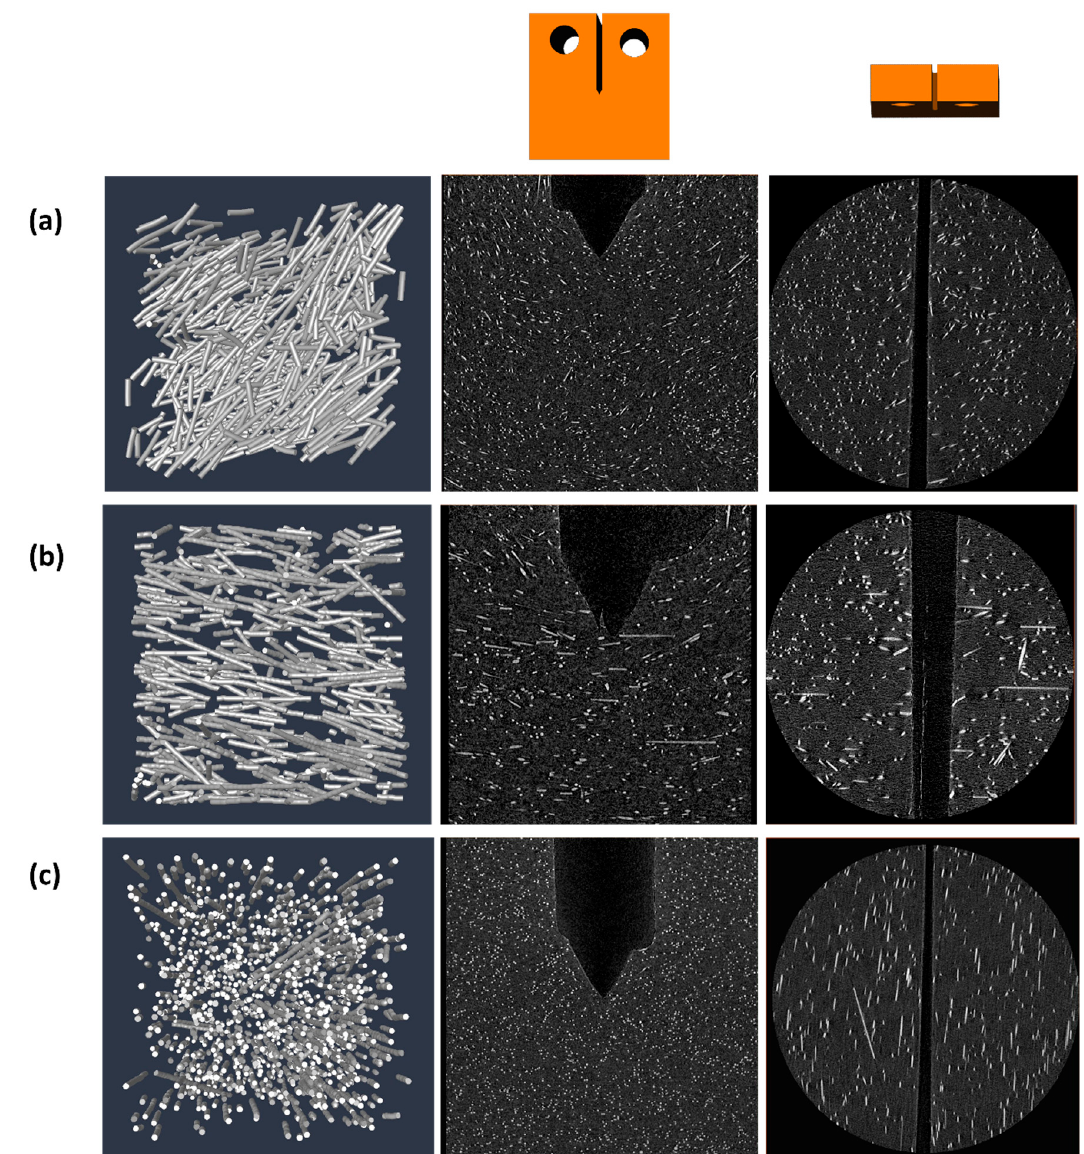
Figure 6. Visualization of fiber orientation by means of Computed Tomography. The left column depicts trace-lines of the fibers from a small representative volume near the crack-tip, the middle column depicts a slice of the XY -plane, and the right column a slice of the XZ -plane above the crack-tip. Each row displays a different magnetic configuration: ( a ) arbitrary orientation in the absence of magnetic field; ( b ) unidirectional alignment with the X -axis, parallel to the direction of the load, by a solenoid; and ( c ) unidirectional alignment with the Z -axis, perpendicular to the load and to the crack propagation vector, by concentrated magnets without any bias field.